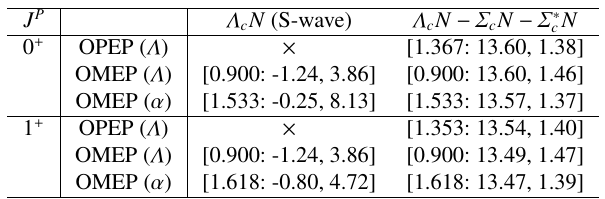
Table 5. Comparison among di ff erent cases. The meaning of the numbers are [cuto ff Λ in GeV or dimensionless α : binding energy in MeV, RMS radius in fm].